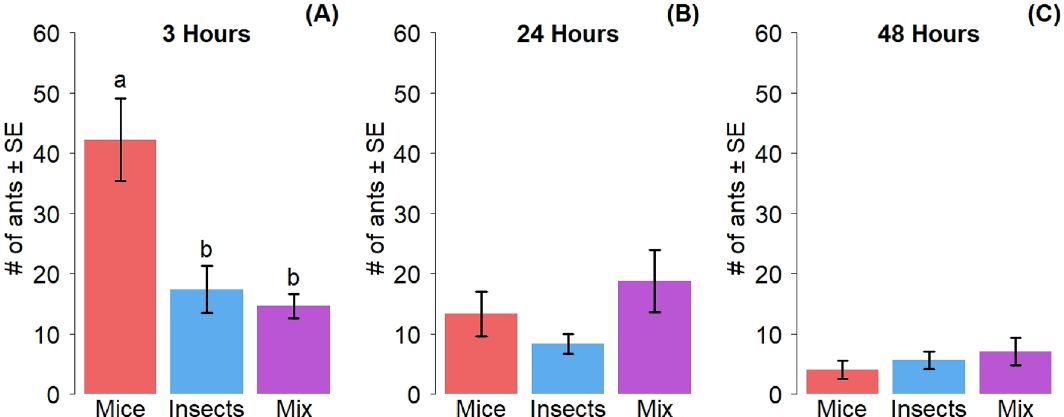
Figure 2. Number of ants counted in food dishes (mean ± SE) as a function of food treatments ( A ) at three hours (n = 6), ( B ) at 24 h (n = 6) and ( C ) at 48 h (n = 6). Letters above bars represent the results of the post- hoc pairwise comparison analysis, bars sharing a letter are not significantly different (P < 0.05). Red = mice, blue = insects, purple = mix.